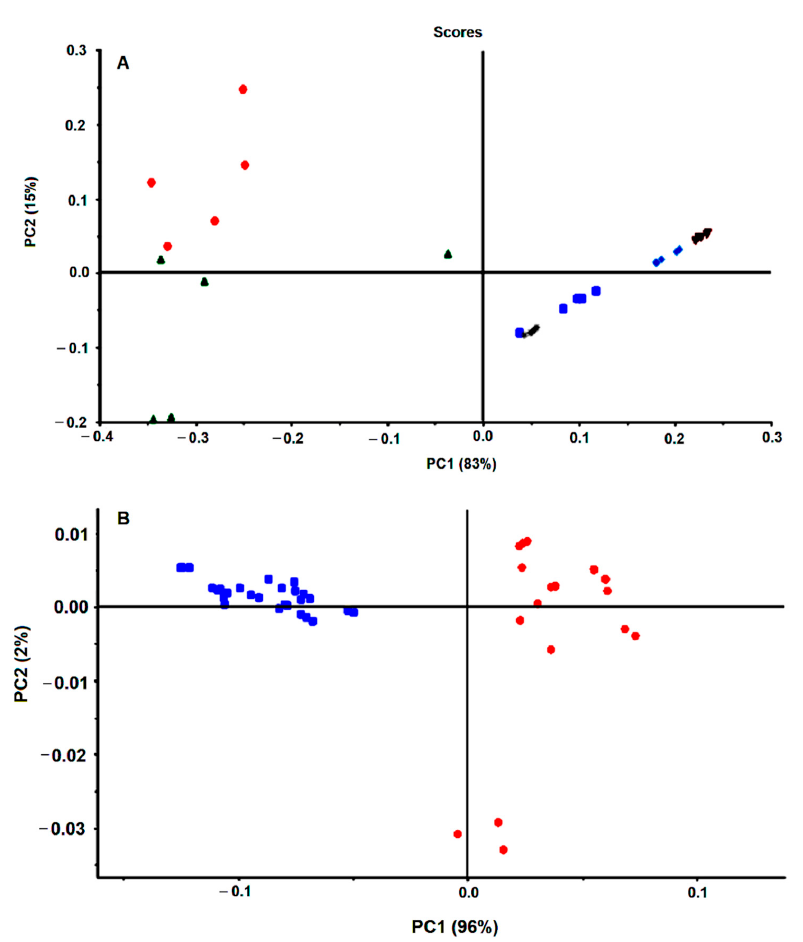
Figure 6. PCA of first derivative spectra of H. pylori strains. ( A ) 26,695 H. pylori (blue) and J99 (red) incubated or not with antimicrobials. ( B ) Six H. pylori strains not incubated with drugs: Blue, 207-99; Red, 939-99; Green, B1-99; Light blue, 927-03; Brown, 1152-04; Grey, 1198-04. H. pylori J99 was submitted to clarithromycin, one of the most common antibiotics applied against H. pylori infection. This antibiotic MIC, against J99 H. pylori, was 15 mg/L. The PCA score-plot incubations with a drug concentration below the MIC, the red symbols to the MIC, and the remaining